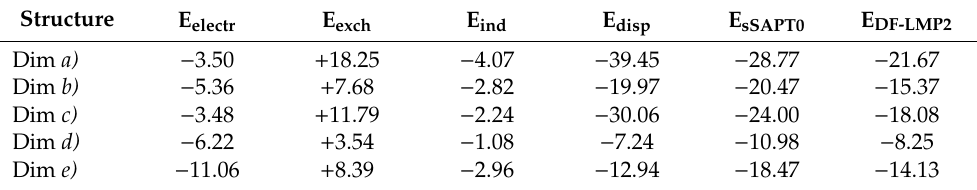
Table 6. The intermolecular energy values and their di ff erent energy components computed at intermolecular energy values obtained at DF-LMP2 levels of theory for the five dimer configurations taken from the Drost2 crystal conformations (all energy values are given in kJ /